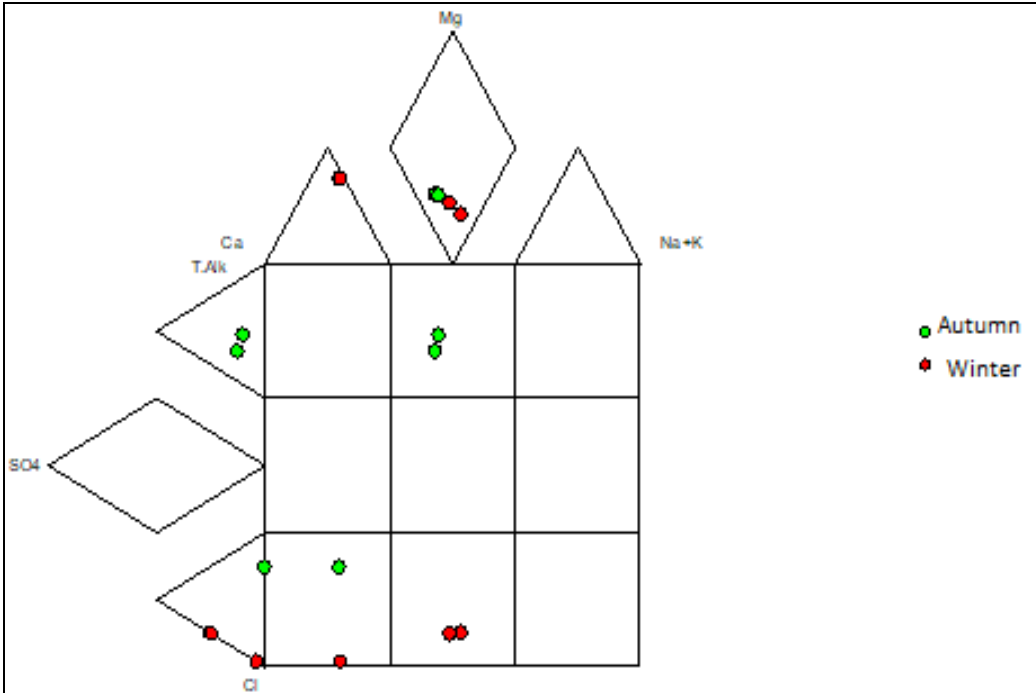
Figure 6. Expanded Durov diagram for groundwater samples in the southern landfill site for the two seasons.